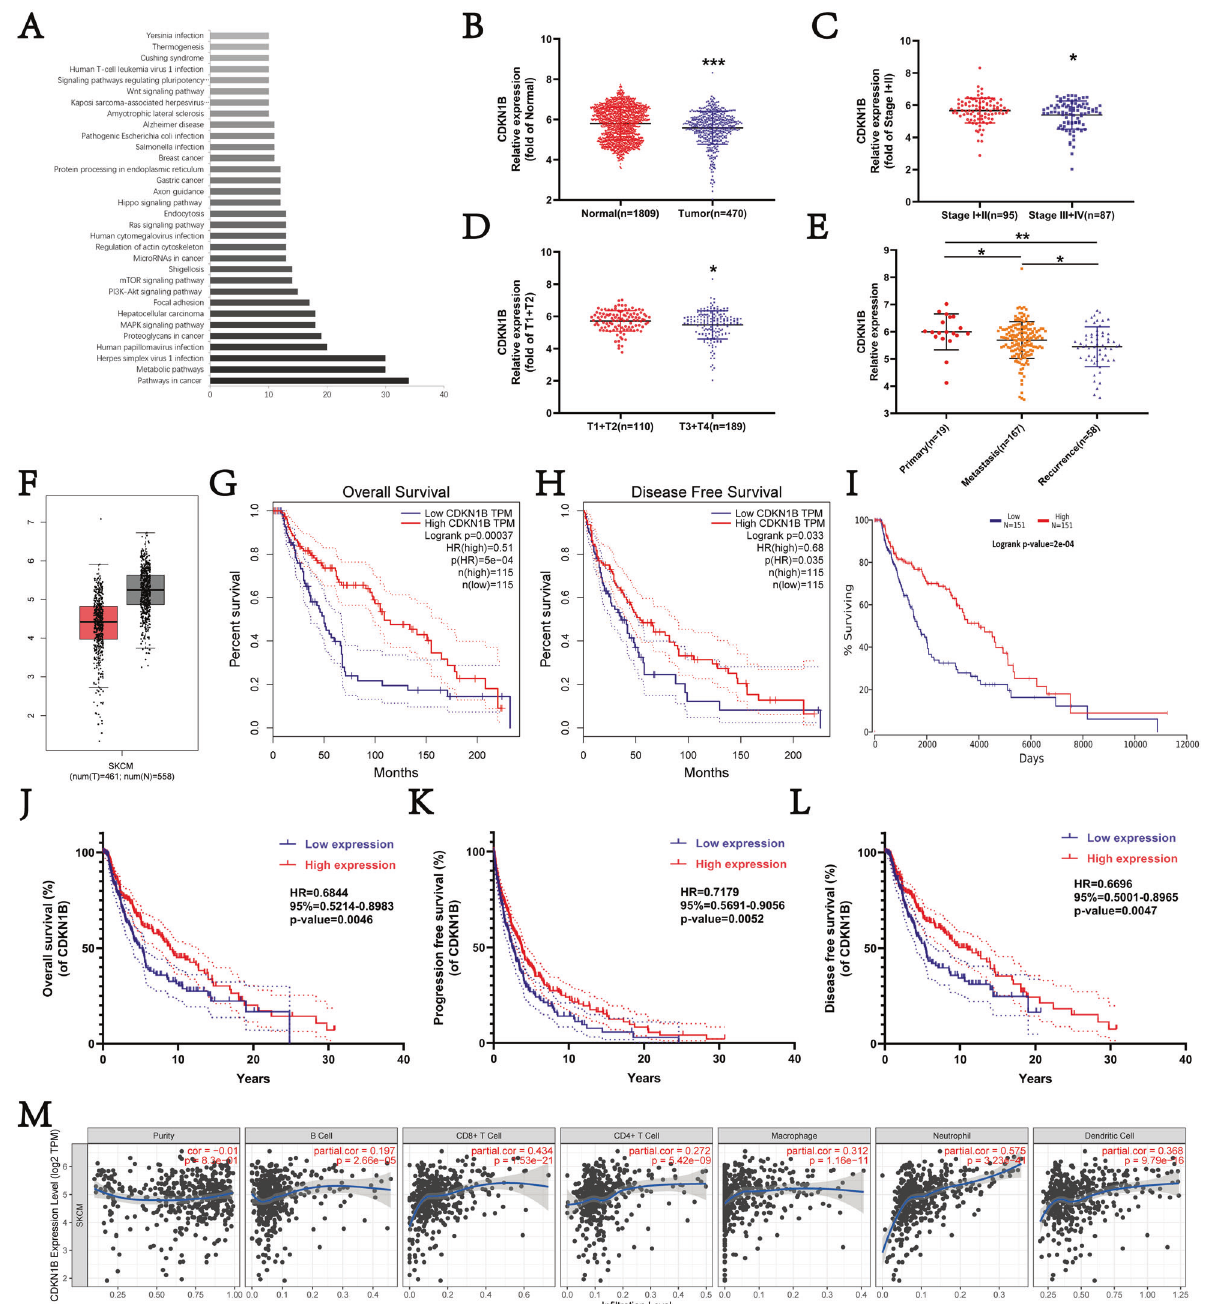
Fig. 4 Bioinformatic analysis of CDKN1B gene in human melanoma. A KEGG pathway analysis of the target genes of miR-199a-1-5p. B – F CDKN1B gene relative expression in melanoma. G – L The Kaplan-plot of CDKN1B gene in patients with melanoma. M The association of CDKN1B expression and immune